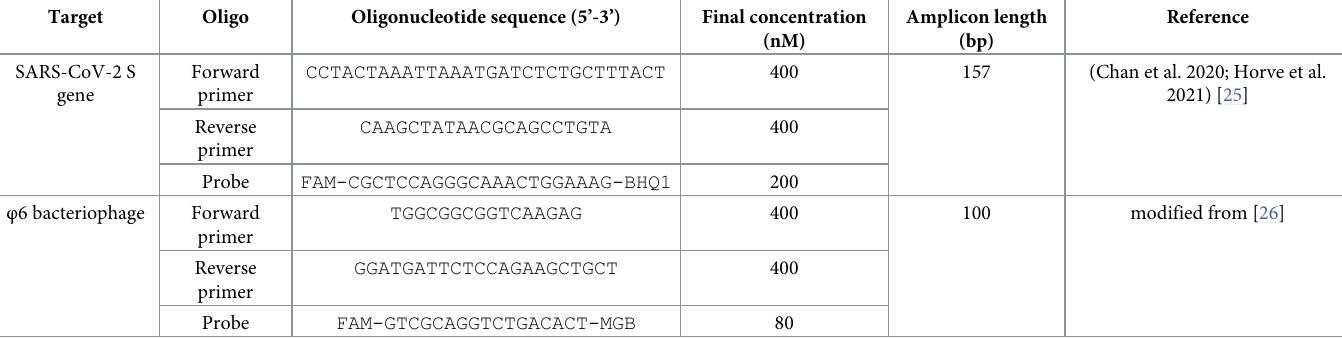
Table 2. RT-qPCR primers and probe used for the detection of SARS-CoV-2 and φ 6 bacteriophage in environmental samples.